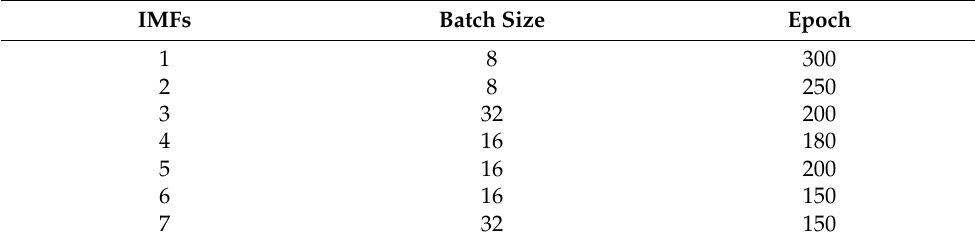
Table 6. Hyper-parameters of LSTM.